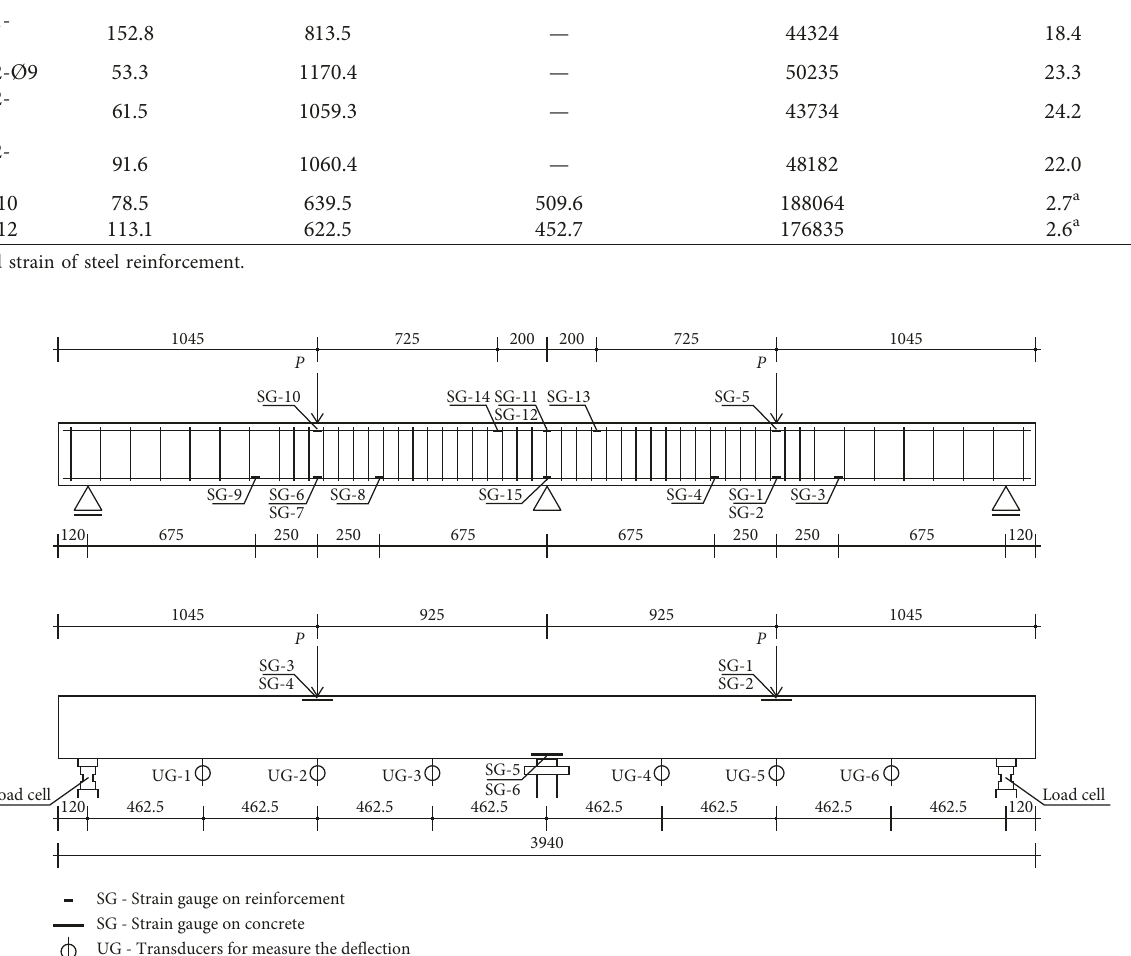
Figure 3: Experimental setup and instrumentation for tested beams (all dimensions are in mm).